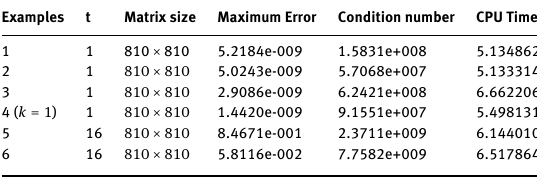
Table 13: Maximum errors E N and condition numbers of coefficient matrices on single domain ( p = q = 1) when N x = 80 and N t = 10.